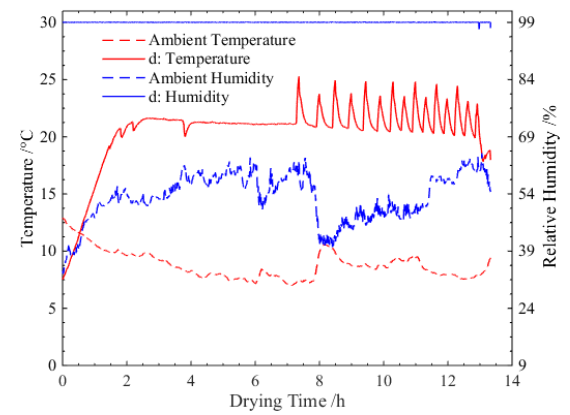
Figure 8. The temperature and relative humidity of the unit-room.